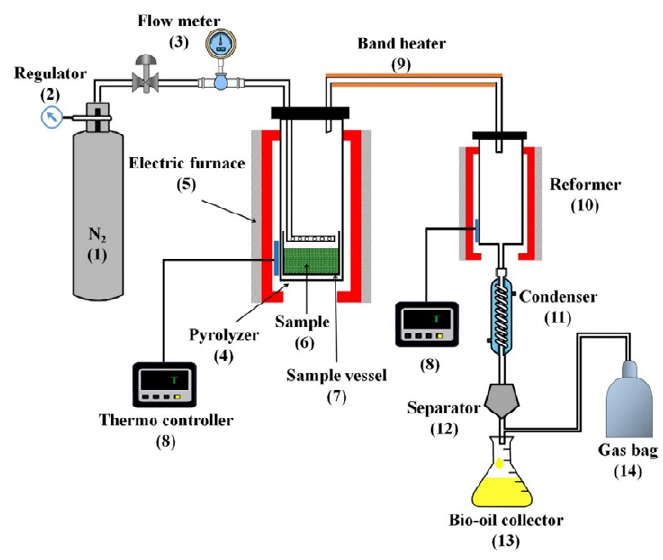
Fig. 1: Schematic representation of the pyrolysis experimental setup